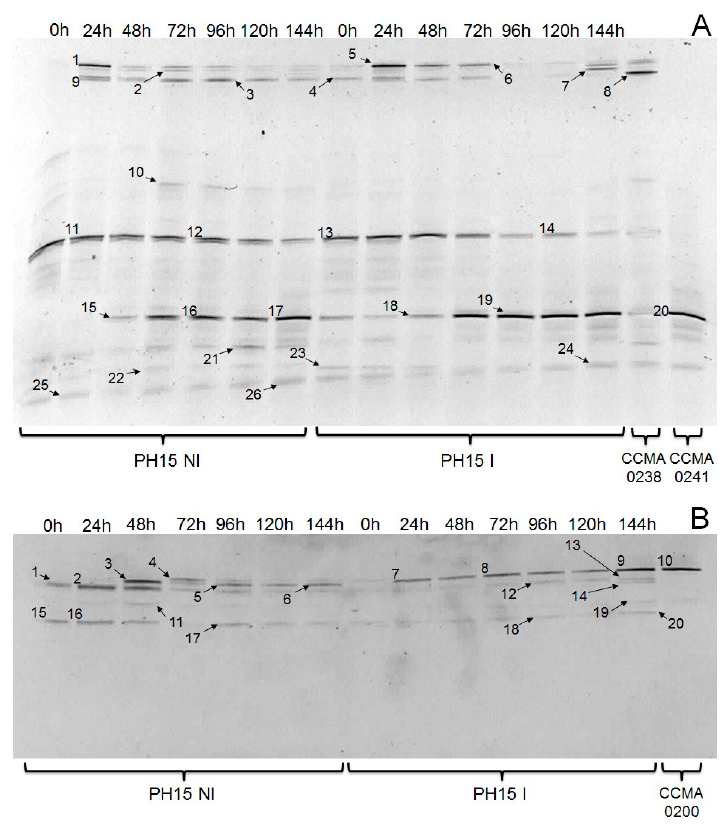
Figure 1. Changes in prokaryote ( A ) and eukaryote ( B ) communities during fermentation of the PH15 cocoa hybrid without (PH15 NI) and with (PH15 I) inoculation, and fingerprints of the starter cultures (CCMA 0238, CCMA 0241, and CCMA 0200). The identities of the bands are presented in Table 1. Bands marked with numbers were excised, re-amplified, and sequenced.